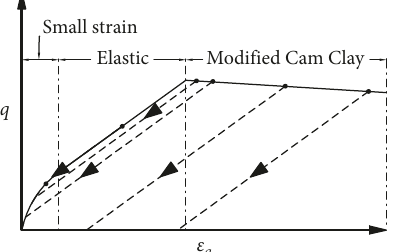
Figure 5: Schematic of unloading from different points.